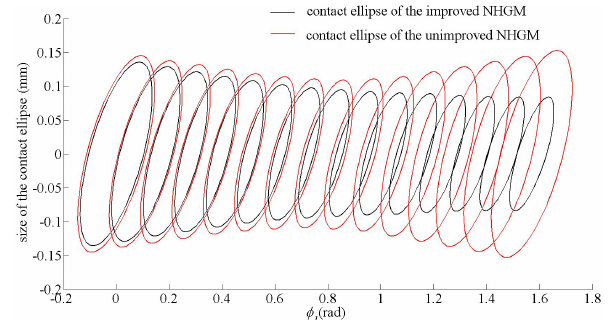
Figure 10. Contact ellipses of the improved and unimproved